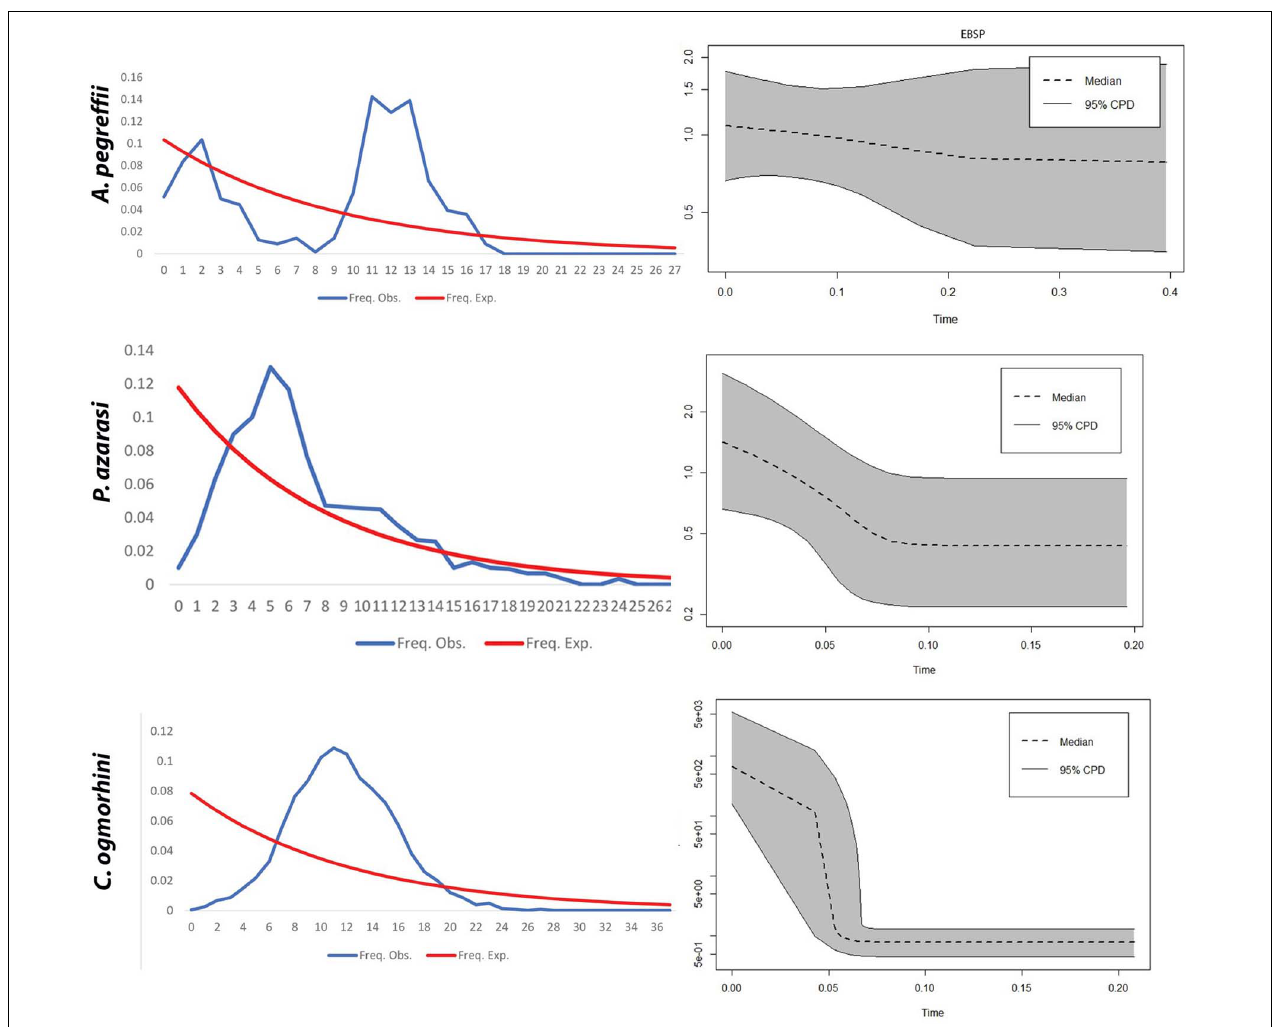
FIGURE 9 | Extended Bayesian Skyline Plot. (A) The x -axis visualizes time before present (Mya), and the y -axis represents effective population sizes (Ne). Gray regions depict confidence intervals [95% highest posterior density (HPD) limits], and the dashed line expresses median value for the log 10 of Ne (effective population size). (B) Mismatch distribution demonstrates the demographic history of Pseudoterranova azarasi , Anisakis pegreffii , and Contracaecum ogmorhini . The dotted line represents the observed distributions, and the solid black curve indicates distributions under a constant-sized population